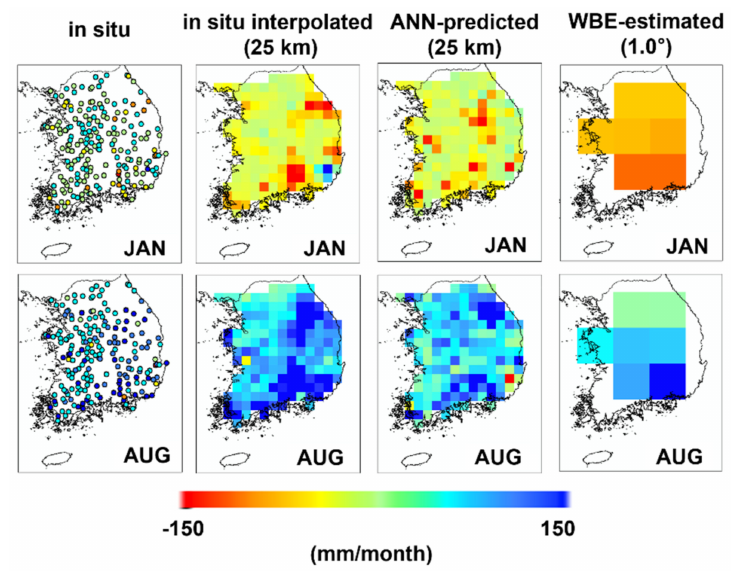
Figure 5. Spatial distribution of monthly ∆ GWS in January and August in 2014.